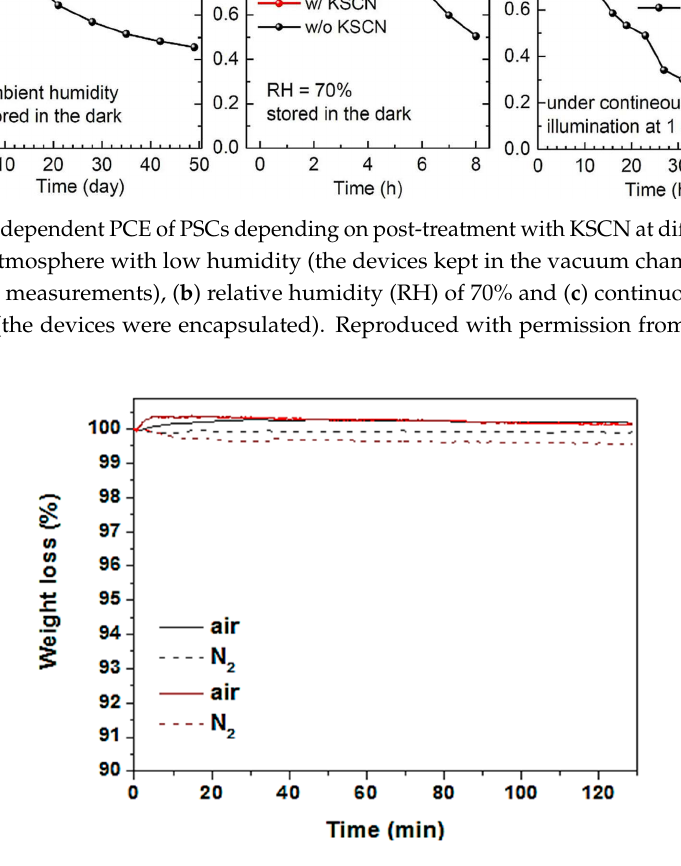
Figure 10. Time-dependent PCE of PSCs depending on post-treatment with KSCN at di ff erent condition of (a) ambient atmosphere with low humidity (the devices kept in the vacuum chamber in the dark before and after measurements), (b) relative humidity (RH) of 70% and (c) continuous illumination under one sun (the devices were encapsulated). Reproduced with permission from Reference [76]. Elsevier 2019.